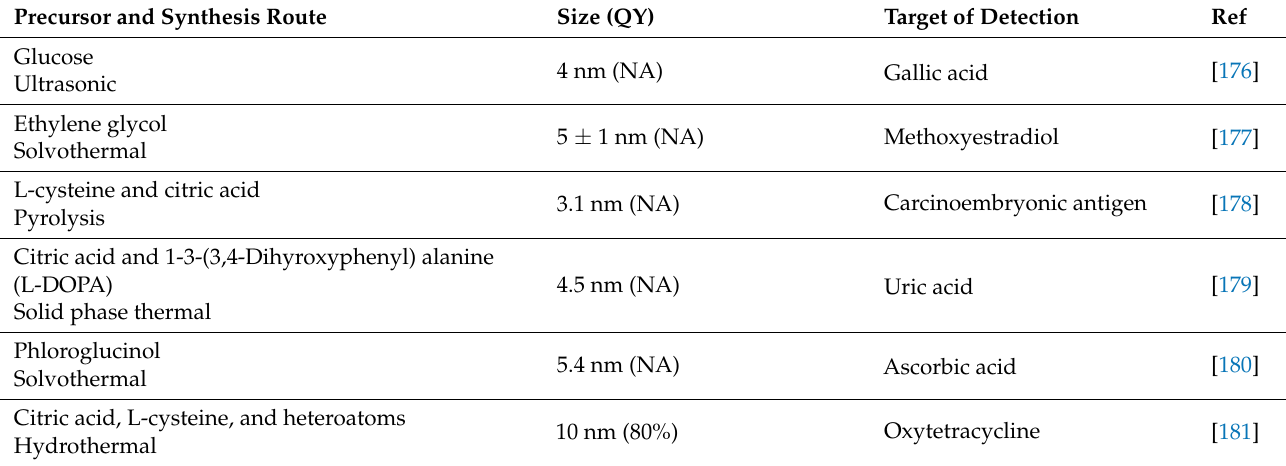
Table 5. Carbon dot-based chemiluminescence